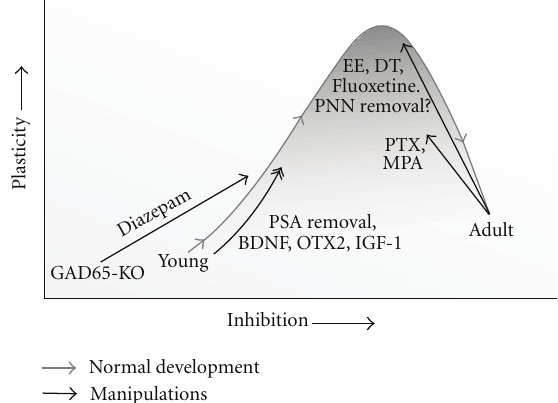
Figure 1: Relationship of inhibition and plasticity during the critical period. Gray line depicts maturation of inhibition and the increase and decline of potential for plasticity during normal development. Black lines show experimental manipulations by which the level of plasticity or inhibition has been artificially altered. EE is environmental enrichment, DT is dark treatment, PNN is perioneuronal net. All manipulations are infusions or injections of substances, except for BDNF which has been overexpressed. See text for